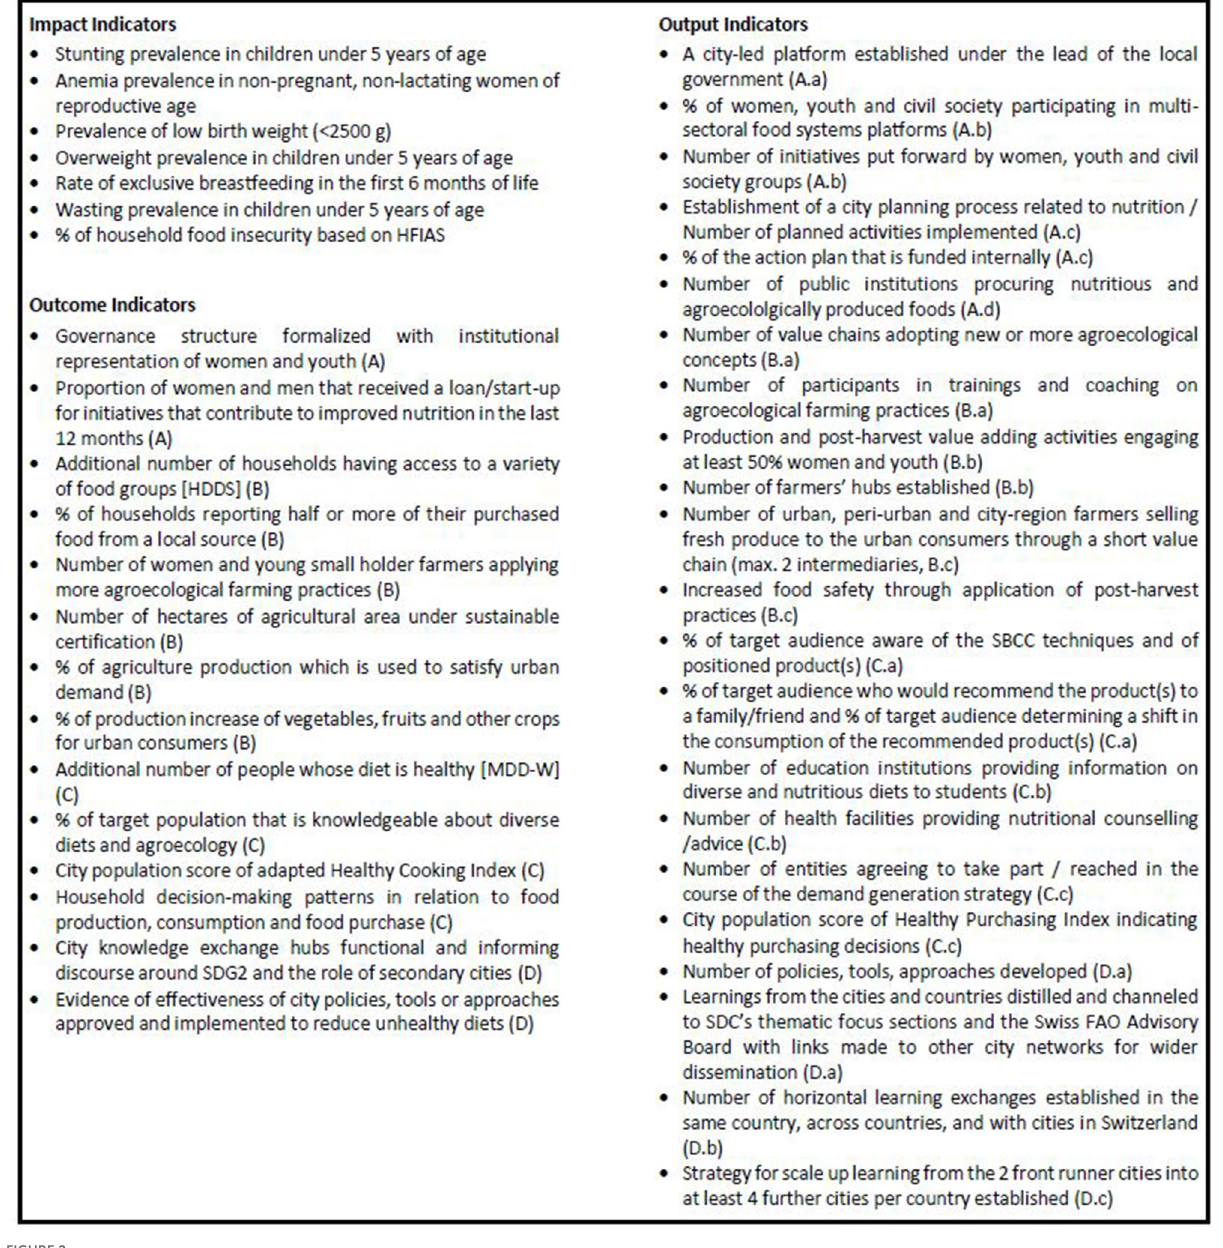
FIGURE2 Monitoring and Evaluation indicators of NICE. A comprehensive, results-oriented M&E system based on a logframe supports the steering of the project and the generation of evidence to contribute to policy dialogue and wider learning via impact, outcomes (A–D referring to outcomes in Figure 1), and output indicators (A.a–D.c referring to outputs in Figure 1). HFIAS, Household Food Insecurity Access Scale; HDDS, Household Dietary Diversity Score; MDD-W, Minimum Dietary Diversity for